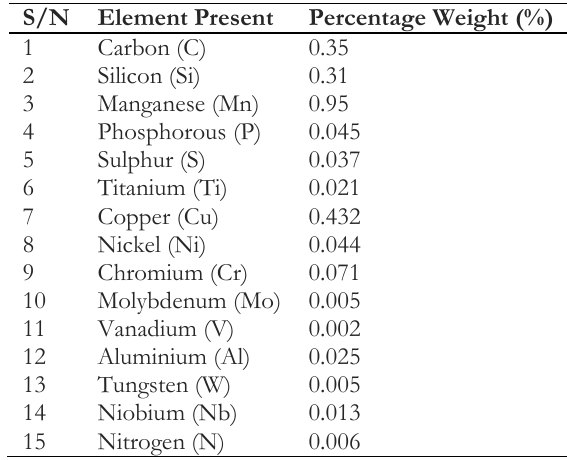
Table 1. Chemical composition of the medium carbon steel sample (wt. %).